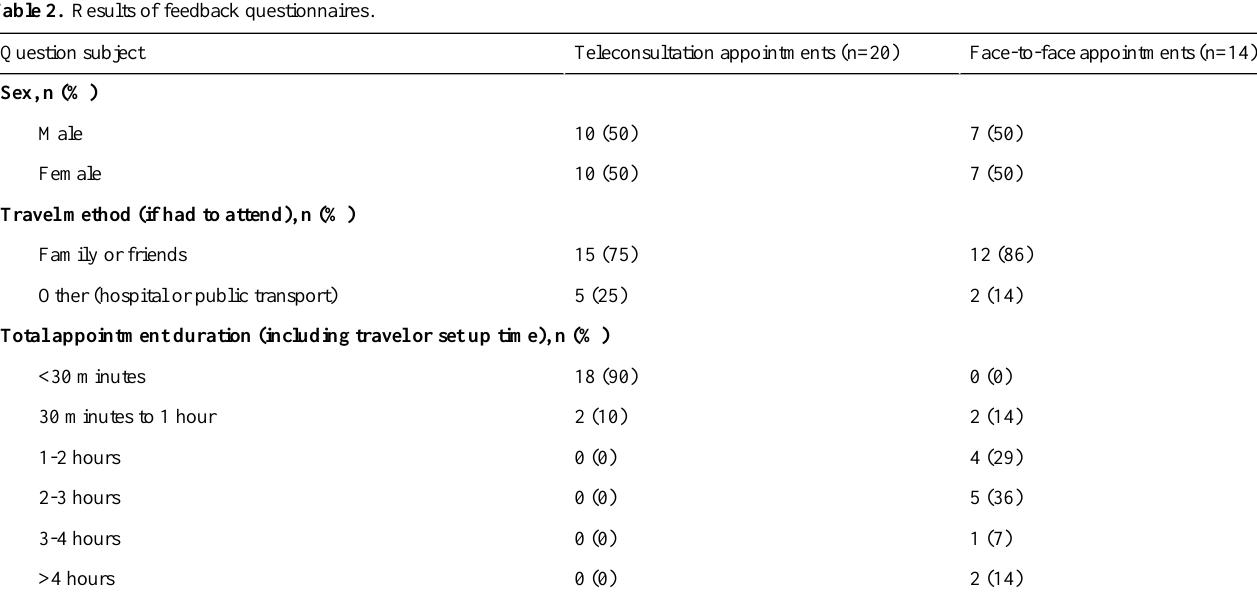
Table 2. Results of feedback